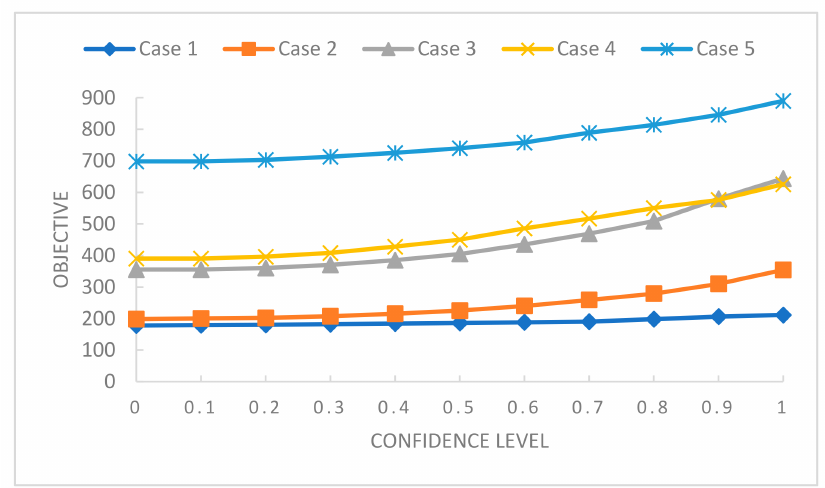
Figure 7. Objective values of different confidence